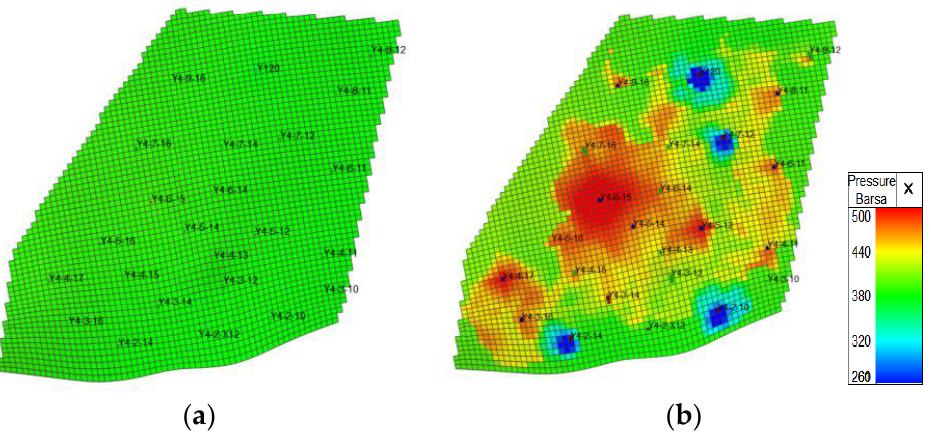
Figure 17. Pressure profile in April 2020: ( a ) Darcy flow; ( b ) non-Darcy flow. Table 1. Calculation results of Darcy and non-Darcy flow.